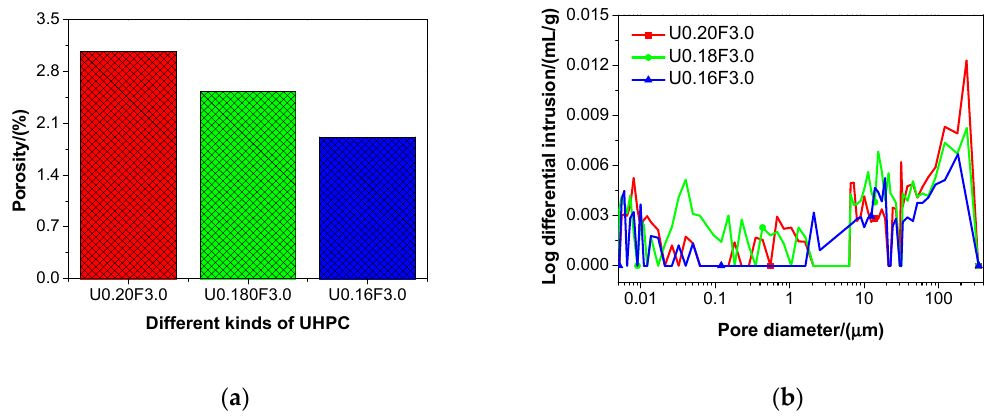
Figure 3. The porosity ( a ) and pore size distribution ( b ) of different kinds of UHPC at 28 days. With respect to the pore size distribution of U0.20F3.0, U0.18F3.0, and U0.16F3.0, there were